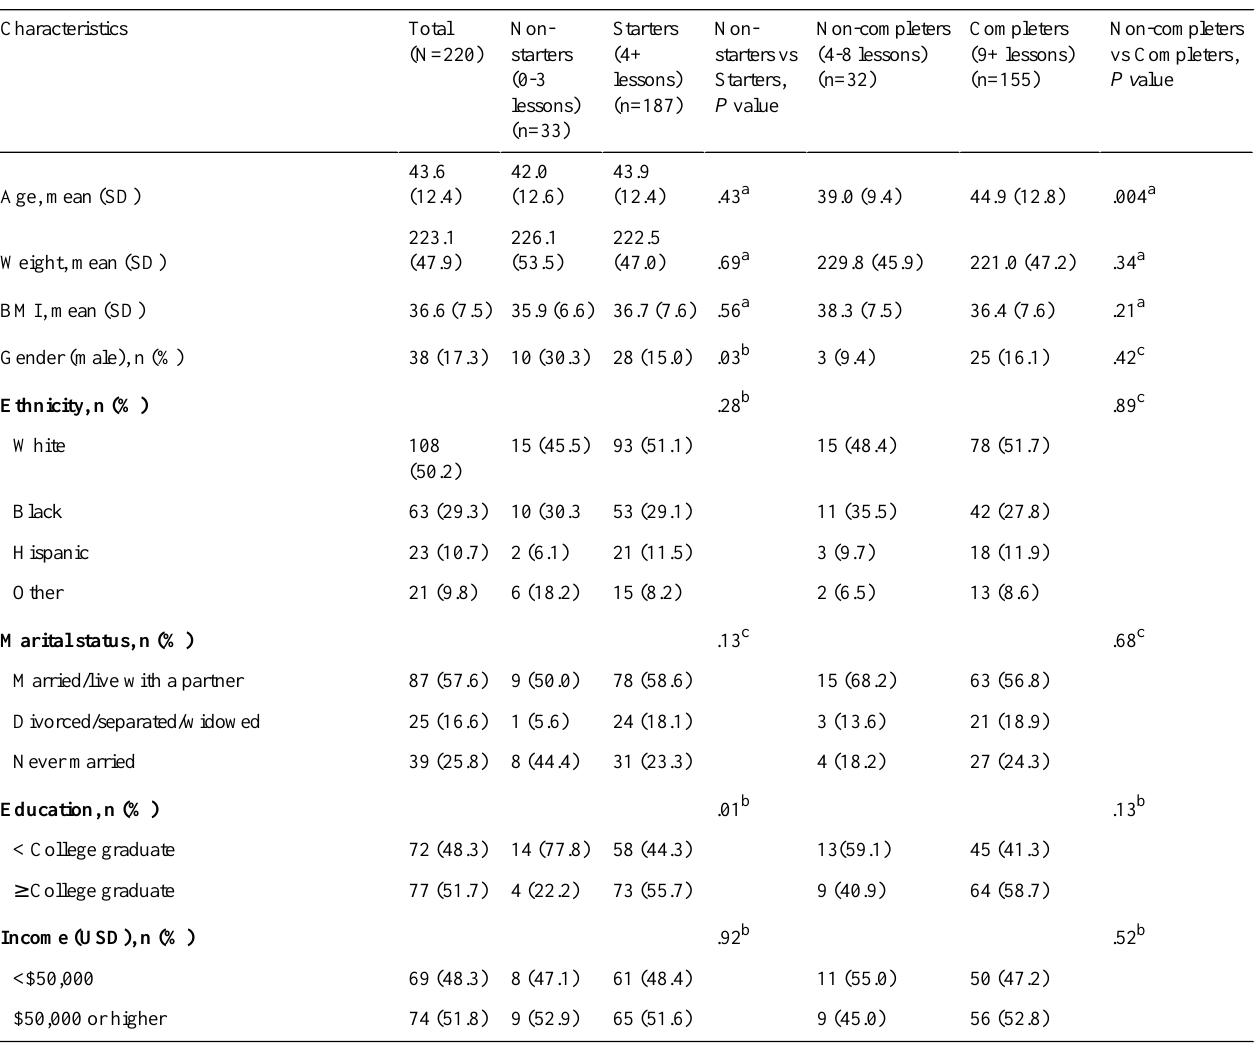
Table 1. Baseline demographic characteristics of participants.